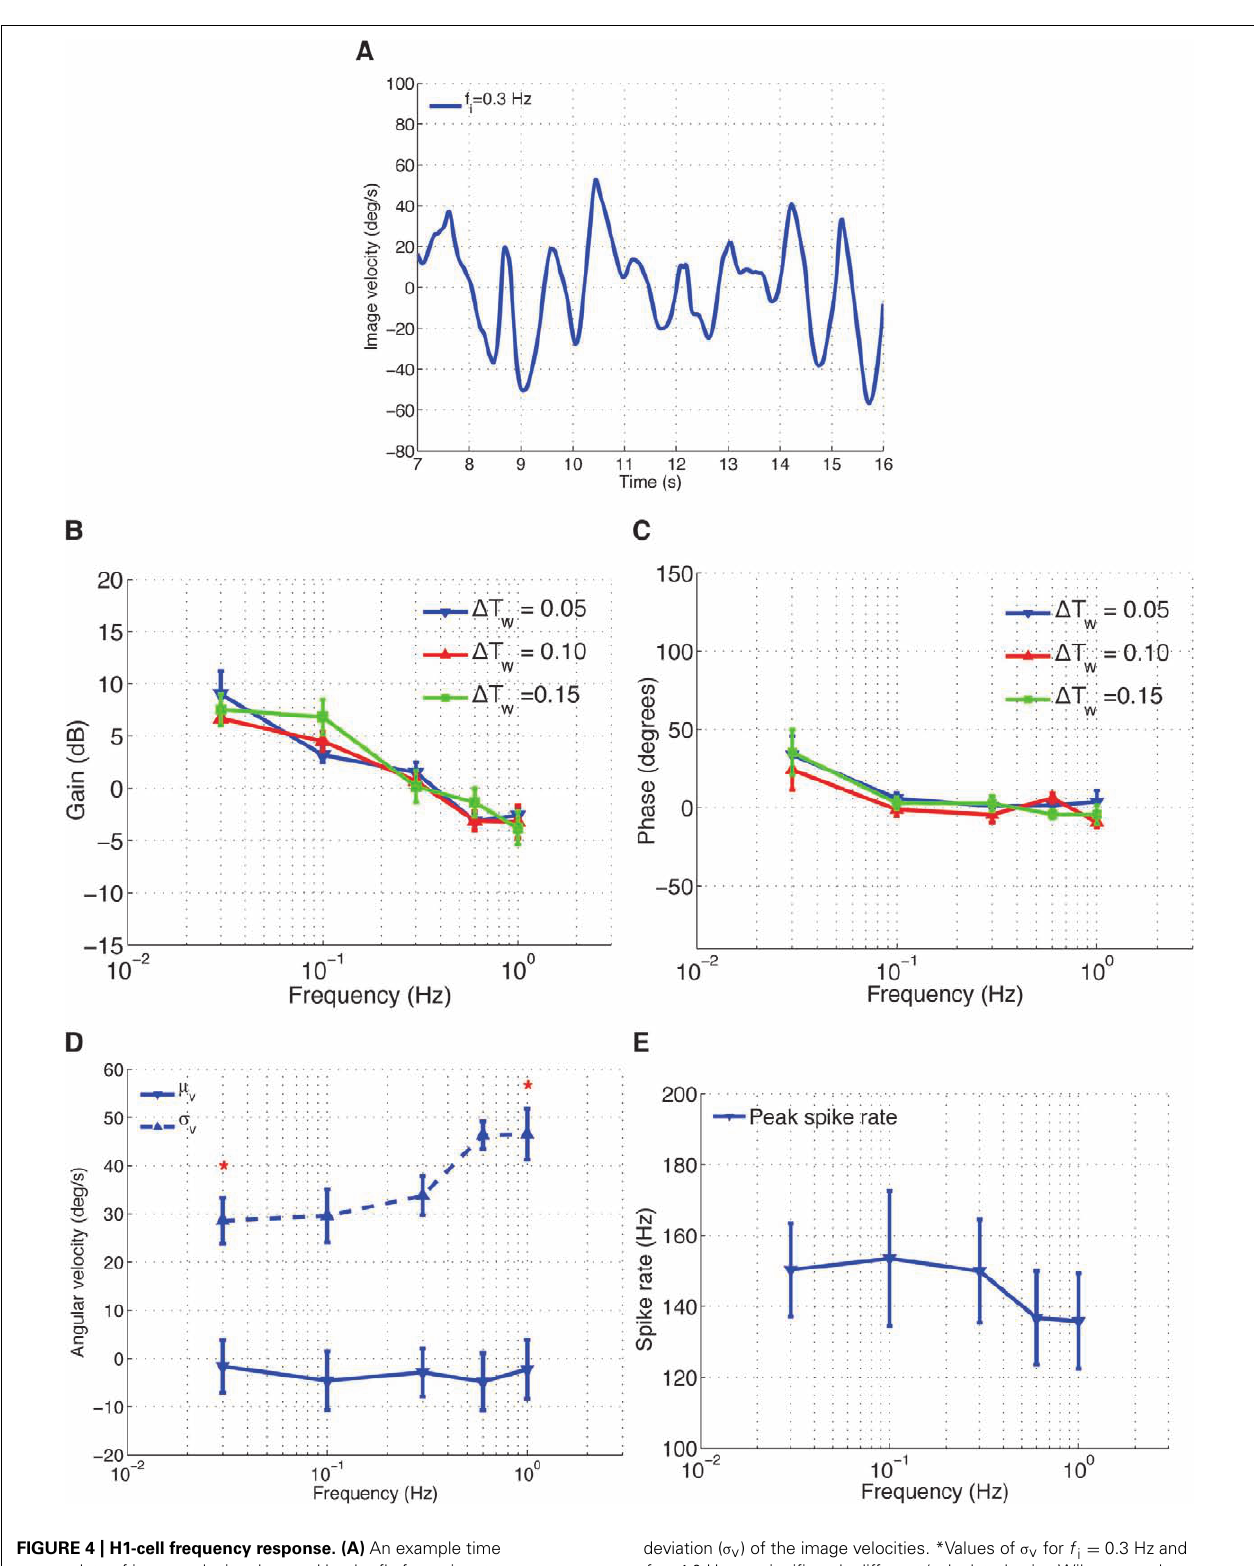
deviation ( σ v ) of the image velocities. *Values of σ v for f i = 0.3 Hz and f i = 1.0 Hz are significantly different (calculated usingWilcoxon rank-sum method with α = 0.001). (E) Peak spike rate (*) for different input